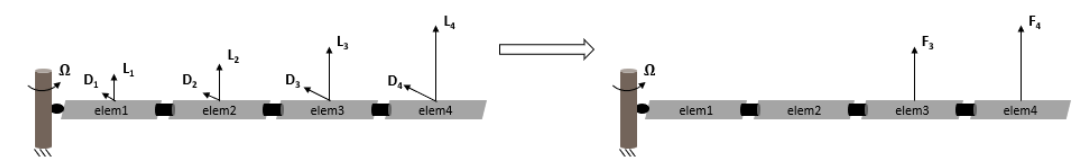
Figure 6. A 4-element blade model with all aerodynamic forces ( left ) and a reduced set of significant forces ( right ).